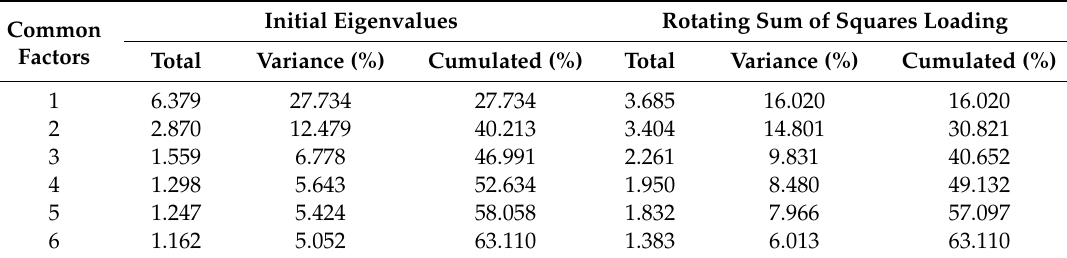
Table 6. Total variance explained.